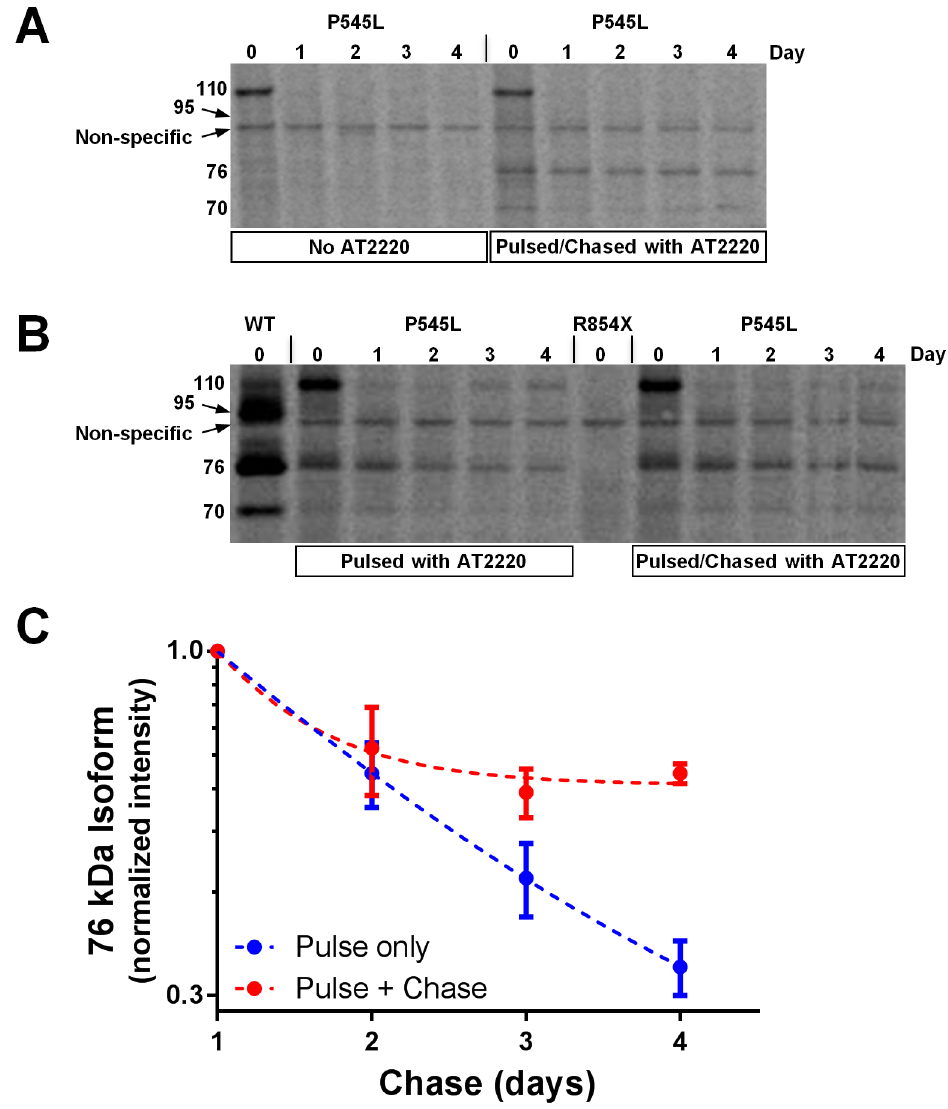
Figure 4. AT2220 increases the stability of mature P545L GAA in lysosomes of Pompe fibroblasts. ( A and B ) P545L GAA fibroblasts were incubated with 100 m Ci 35 S-cysteine/methionine for 3 days, chased for 0 to 4 days, then harvested and lysed. Incubation with 100 m M AT2220 during the pulse only, the pulse and the chase, or neither was performed as indicated. Isoforms of GAA (denoted as the 110, 95, 76, and 70 kDa species) were immunoprecipitated from cell lysates, separated by SDS-PAGE, and imaged with a phosphorimager. As controls, immunoprecipitates from metabolically labeled wild-type (denoted as ‘WT’ in the figure) and R854 6 fibroblasts (both in the absence of AT2220) were also evaluated. ( C ) Levels of the mature 76 kDa isoform of P545L GAA were quantified, normalized against the levels present at the 1-day chase time point, and plotted as a function of time. The data were fitted with an exponential function to estimate the half-life of the 76 kDa isoform of P545L GAA in the presence or absence of AT2220. The 1-day chase time point was chosen as time 0 for the exponential fit in order to eliminate the potential contribution of labeled 110 kDa precursor to the 76 kDa pool.